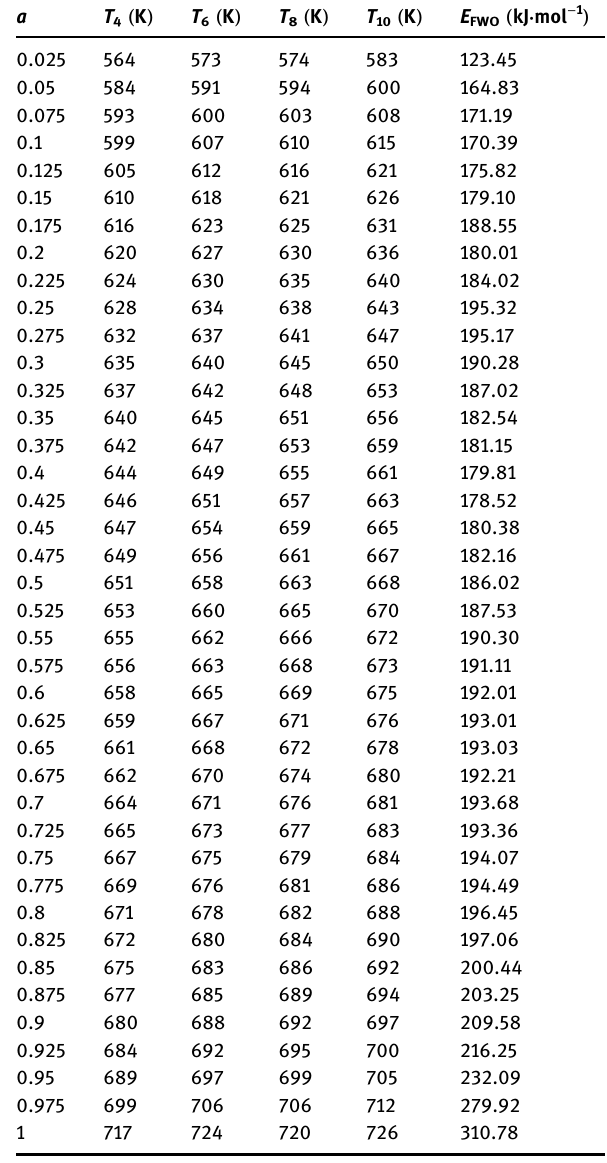
Table 3: Activation energy value calculated by Flynn – Wall – Ozawa method using T – a